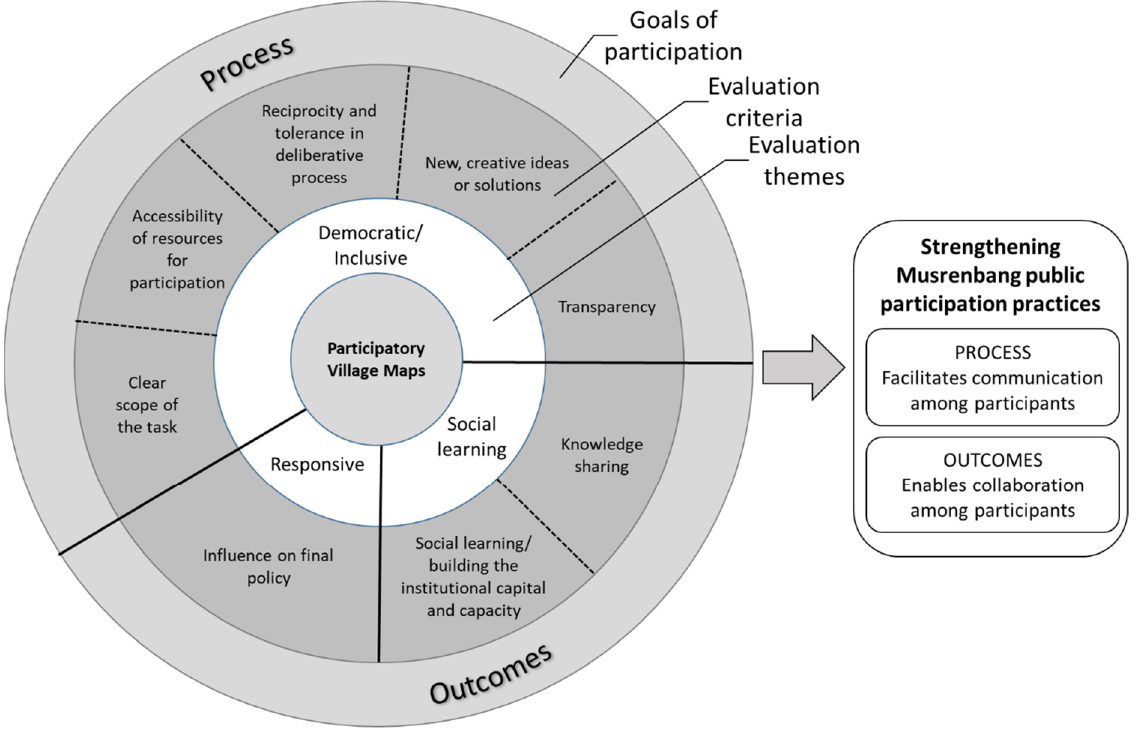
Figure 1. A conceptual framework to assess how village maps produced during participatory mapping activities can strengthen Musrenbang practice.